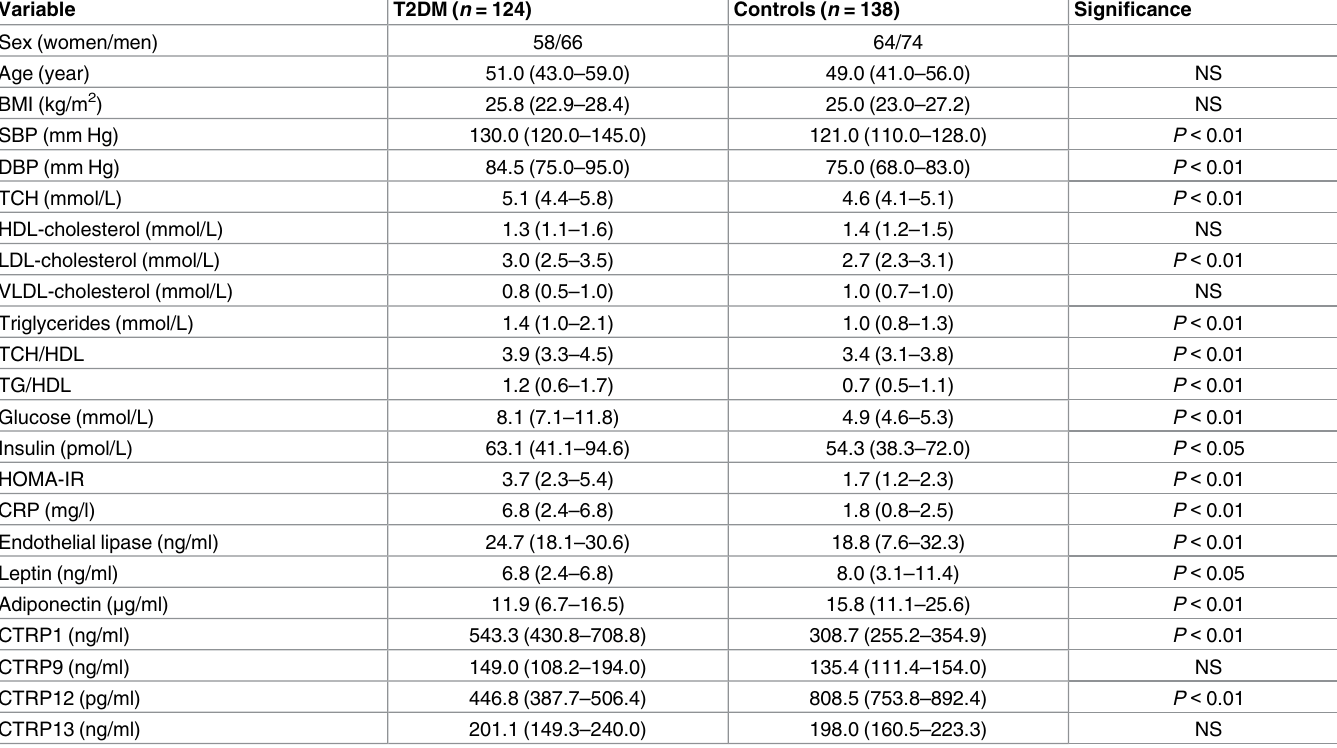
Table 1. Clinical, hormonal and metabolic features of study subjects; circulating levels of CTRP1, 9, 12 and 13, are derived from overnight fasted patient blood